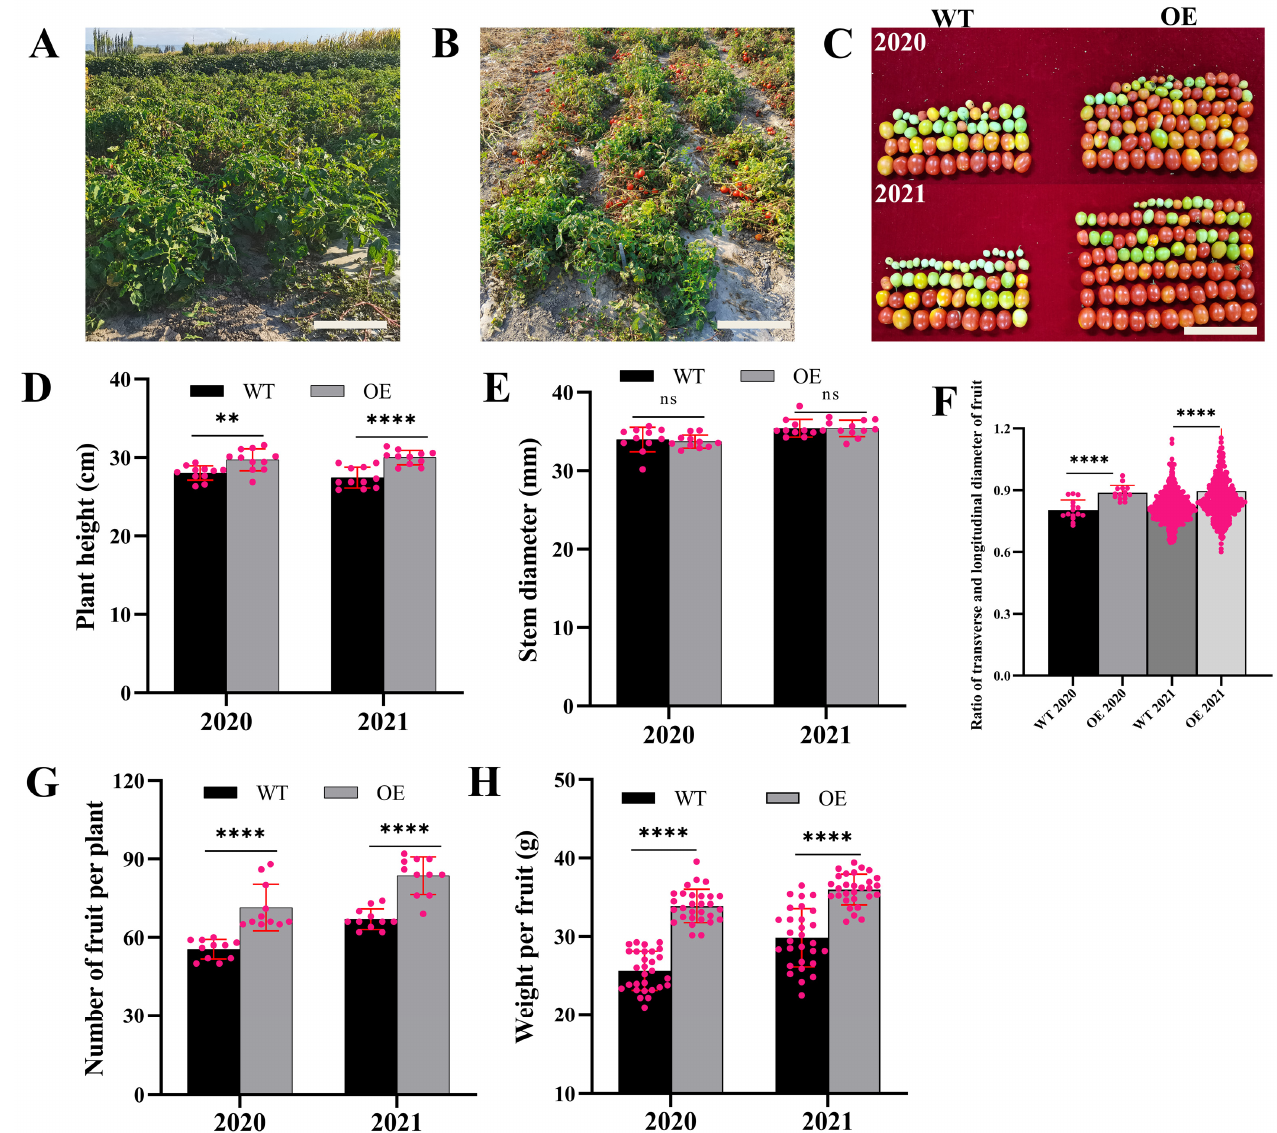
Figure 5. Agronomic characters analysis of wild-type and transgenic tomato. ( A ) Overall growth status of tomato plants during vegetative growth period. Bar = 25 cm. ( B ) Overall growth status of tomato plants during fruit ripening. Bar = 25 cm. ( C ) Yield comparison between wild-type and transgenic tomatoes in 2020 and 2021. ( D ) Plant height. ( E ) Stem diameter. ( F ) The ratio of transverse diameter to the longitudinal diameter of fruits. ( G ) Number of fruits per plant. ( H ) Weight per fruit. Data are means ± SD of three replicates. Each red dot represents a sample. Ns indicate no significant difference between the wild-type and transgenic lines. Asterisk(s) indicate significant difference between the wild-type and transgenic plants by Student’s T-tests: ** p < 0.01 and **** p <